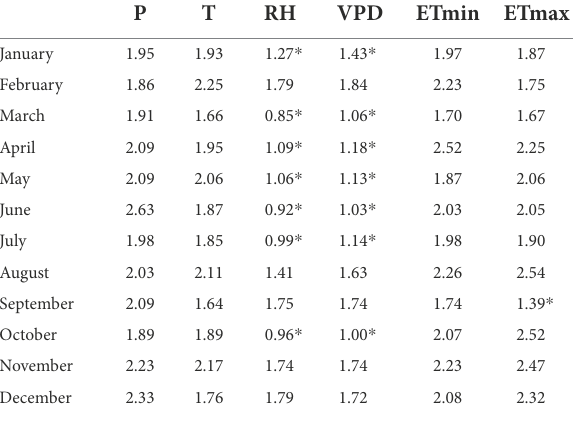
TABLE 3 First-order autocorrelation coefficients for climate data.